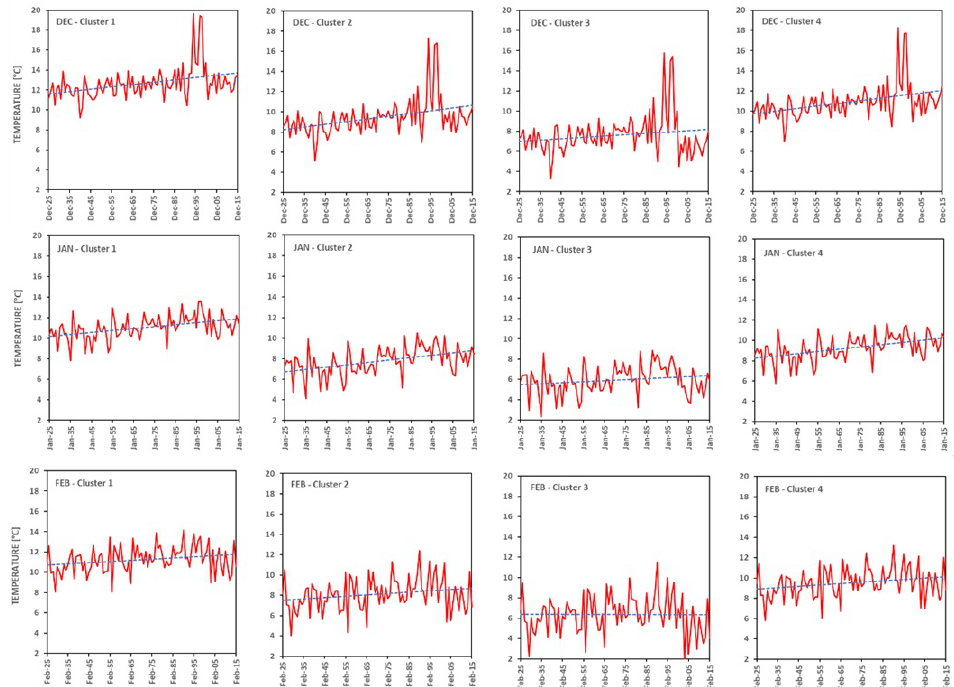
Figure 3. Trend of average monthly temperatures from 1925 to 2015 for each Cluster (quarter Dec-Jan- Feb).